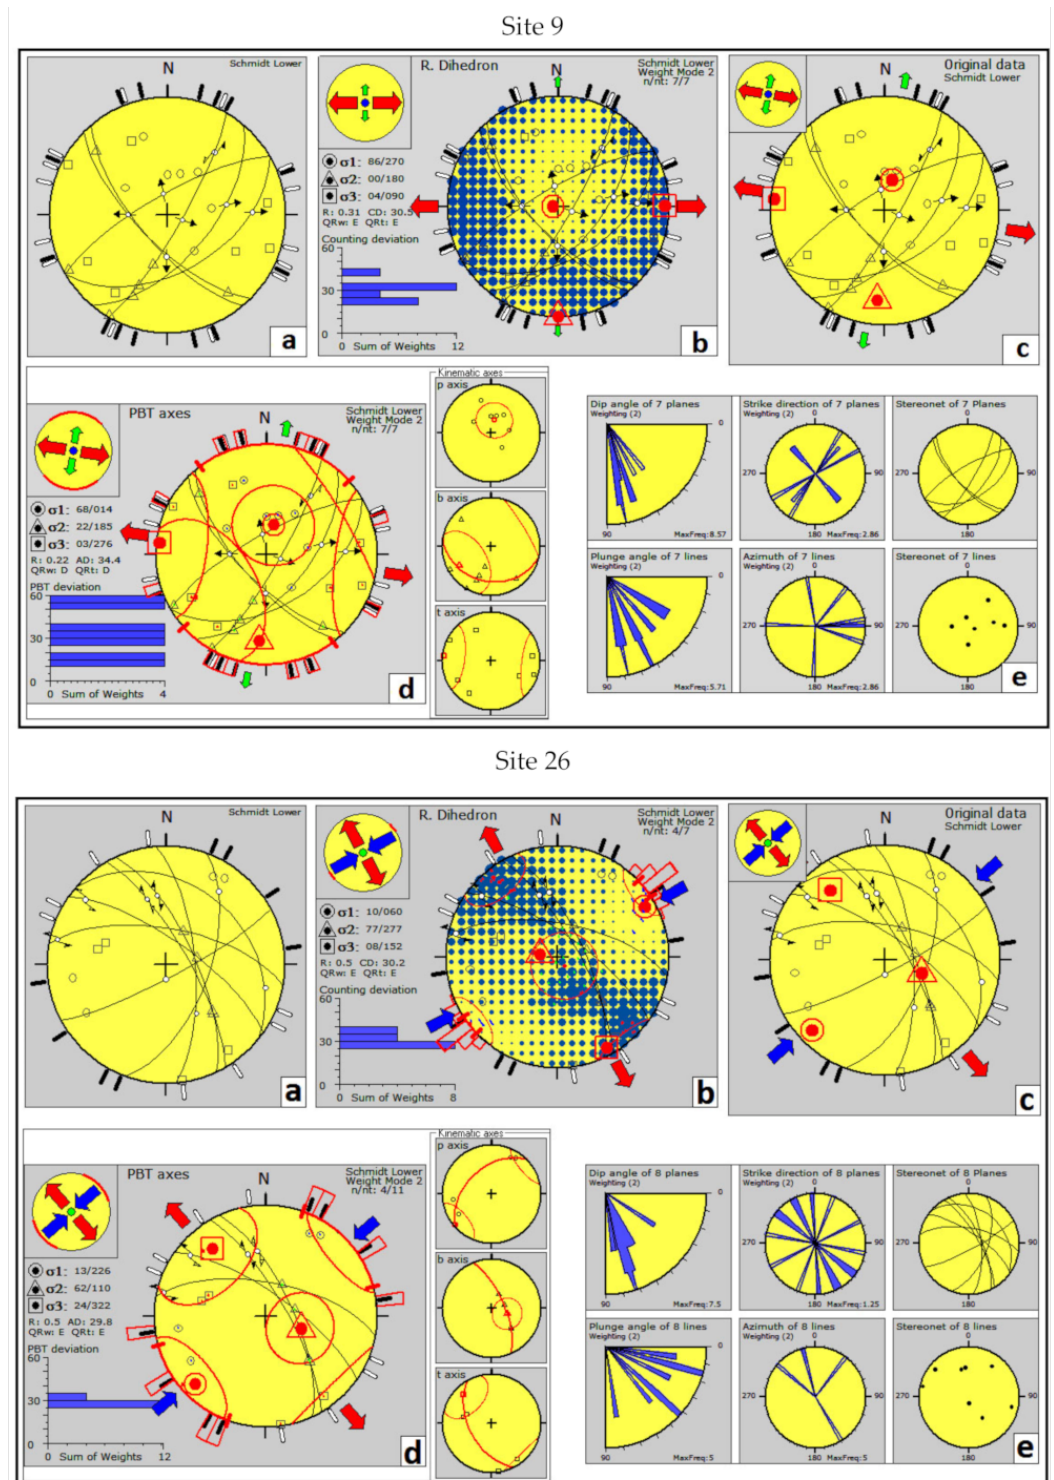
Figure 7. Stress determination for upper Cretaceous units on site 17; Eocene units on site 20; Andesite and Dacite units of Oligocene on site 9; Quaternary units on site 26. ( a ) Stereoplot of faults. ( b ) Right Dihedron method. ( c ) Original data. ( d ) PBT axes method. ( e ) Rose diagram and stereonet of planes and lines. R: stress ratio, QRt: the tensor quality rank, QRw: quality rank for geological indicators, n / nt : ratio of fault-slip data used relative to the total number